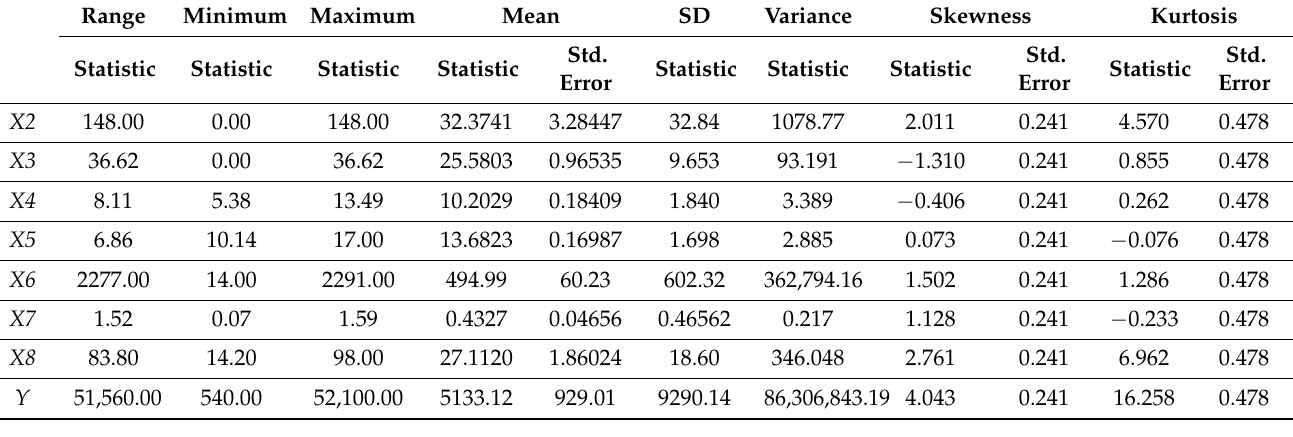
Table 4. Descriptive statistics of the collected samples (Std. Error = standard error, SD = standard deviation).